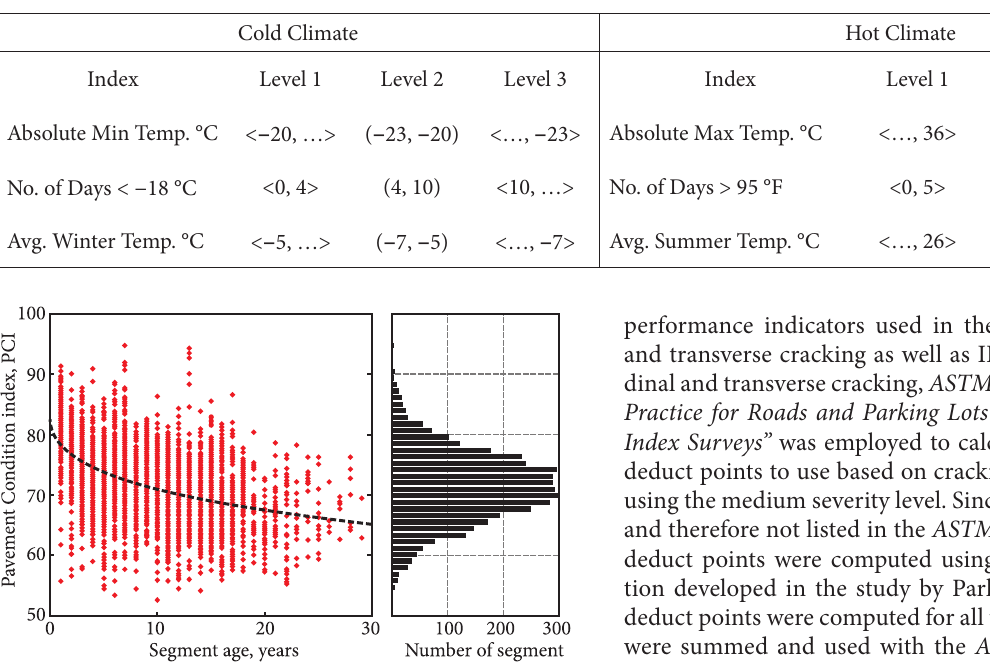
Table 1. Index ranges used for interpolating cold and hot climate regions